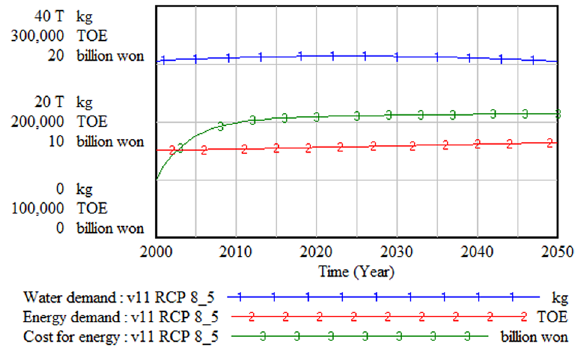
Figure 15. Water, energy demand, and energy cost. TOE = tonne of oil equivalent.